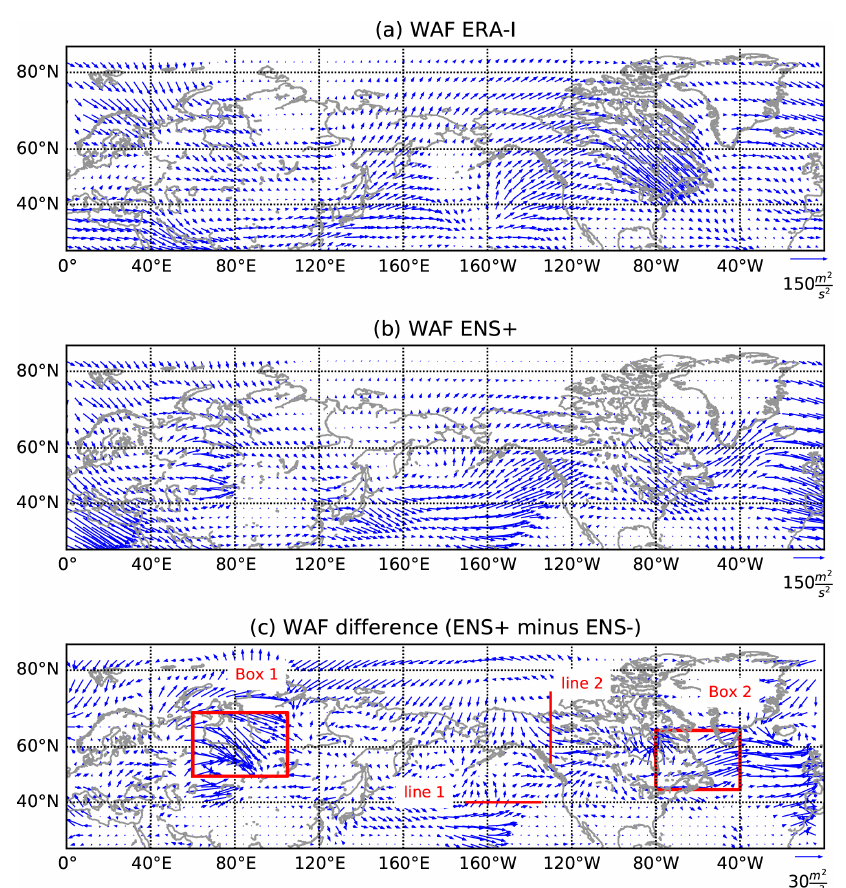
Figure 11. The 500hPa horizontal WAF (m 2 s − 2 ) averaged over 5–7 February. (a) ERA-Interim; (b) ENS + ; (c) difference between ENS + and ENS − groups of ensemble members.